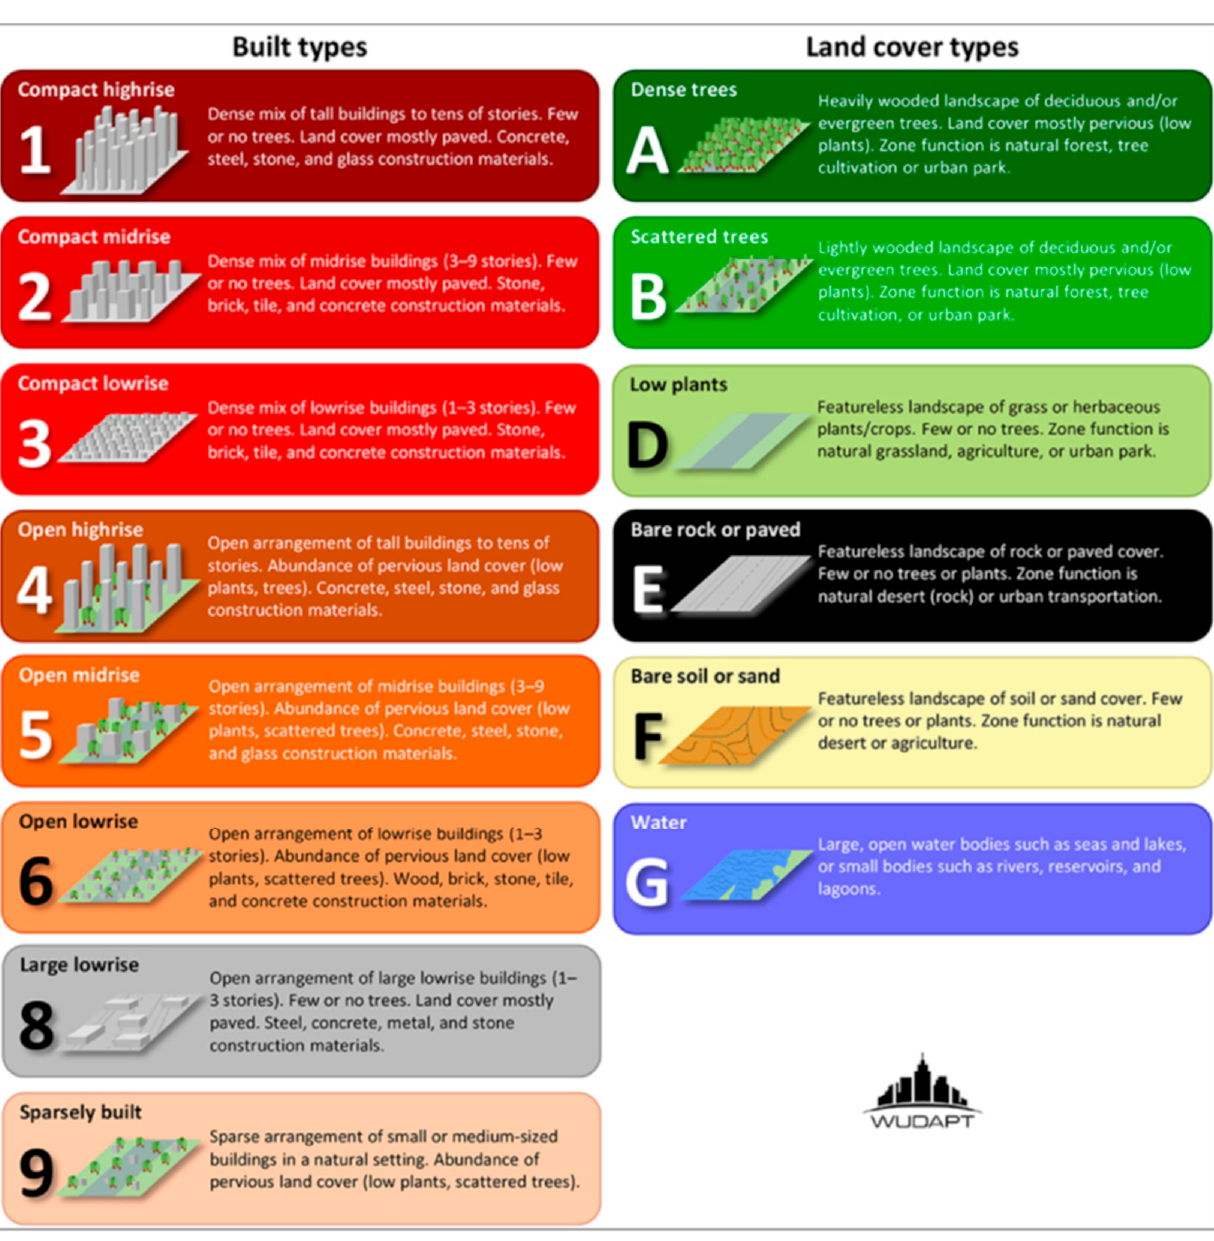
Figure 8. Land cover types of LCZs identified in Balneário Camboriú. Source: [6]. In the urban area of Balne á rio Cambori ú , LCZ 1 is close to the Atlantic Ocean and LCZ 03 is further from the Atlantic Ocean. In the surroundings of LCZ 3, it is possible to see the other LCZs—LCZ A, LCZ B and LCZ D—as well as the sand strip of the LCZ F beach and the presence of water represented by LCZ G (Figure 9). Point 0 is of type LCZ D, but it is not included in the map in order to give more prominence to urban